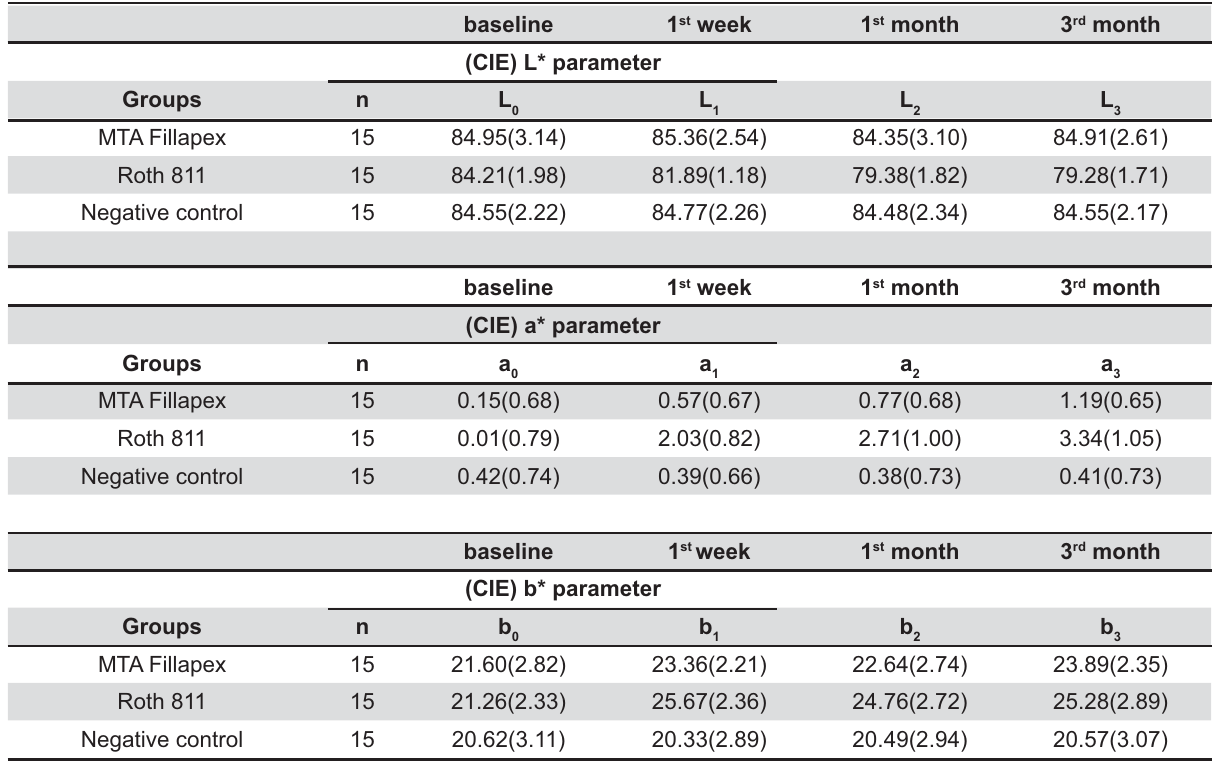
Table 1- CIE L*, a*, b* mean standard deviation values of Groups 1-3, in all experimental